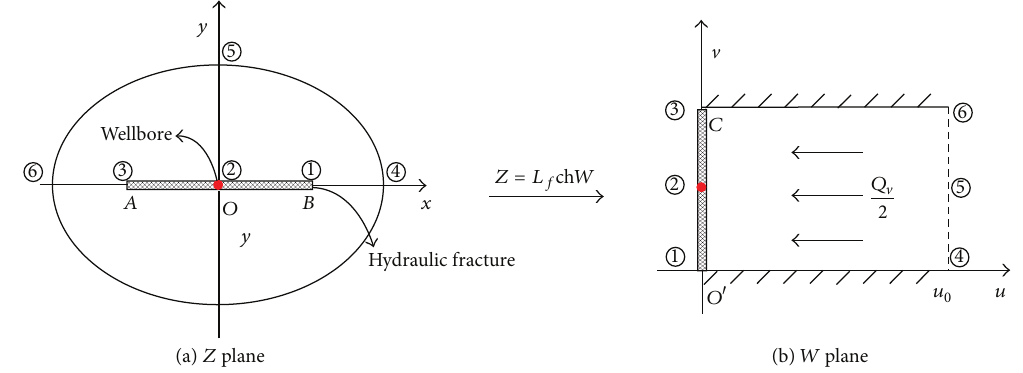
Figure 3: Sketch map of conformal transformation to fractured well.